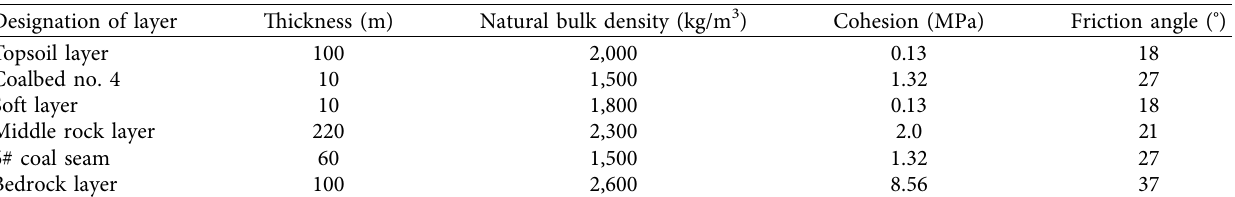
Table 7: Strata division for slope stability calculation and physical and mechanical parameters for sliding slope stability calculation.